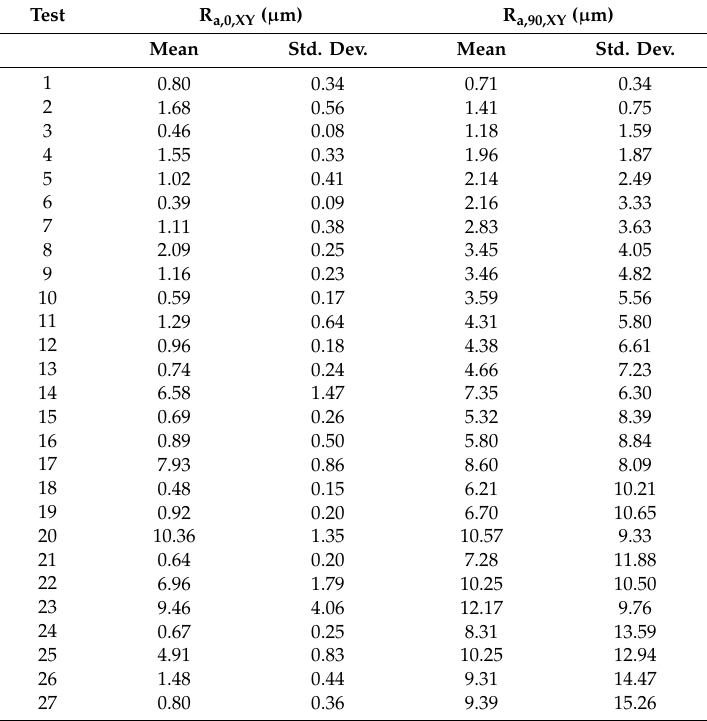
Table 5. Mean and standard deviation of surface roughness for XY specimens.